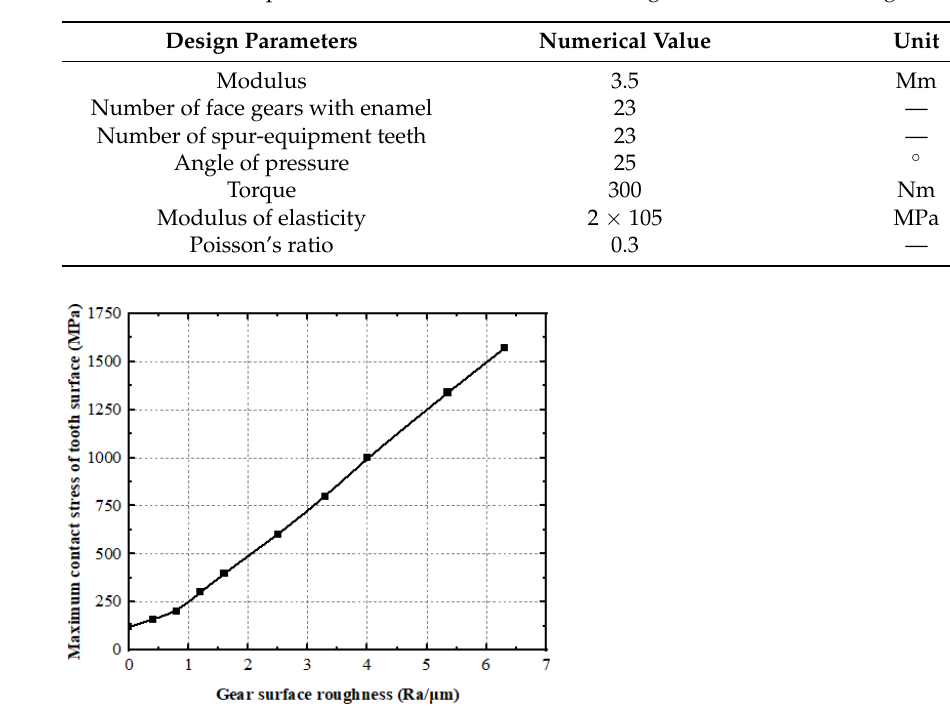
Table 3. Calculation parameters of contact stress on the rough tooth surface of face gears.